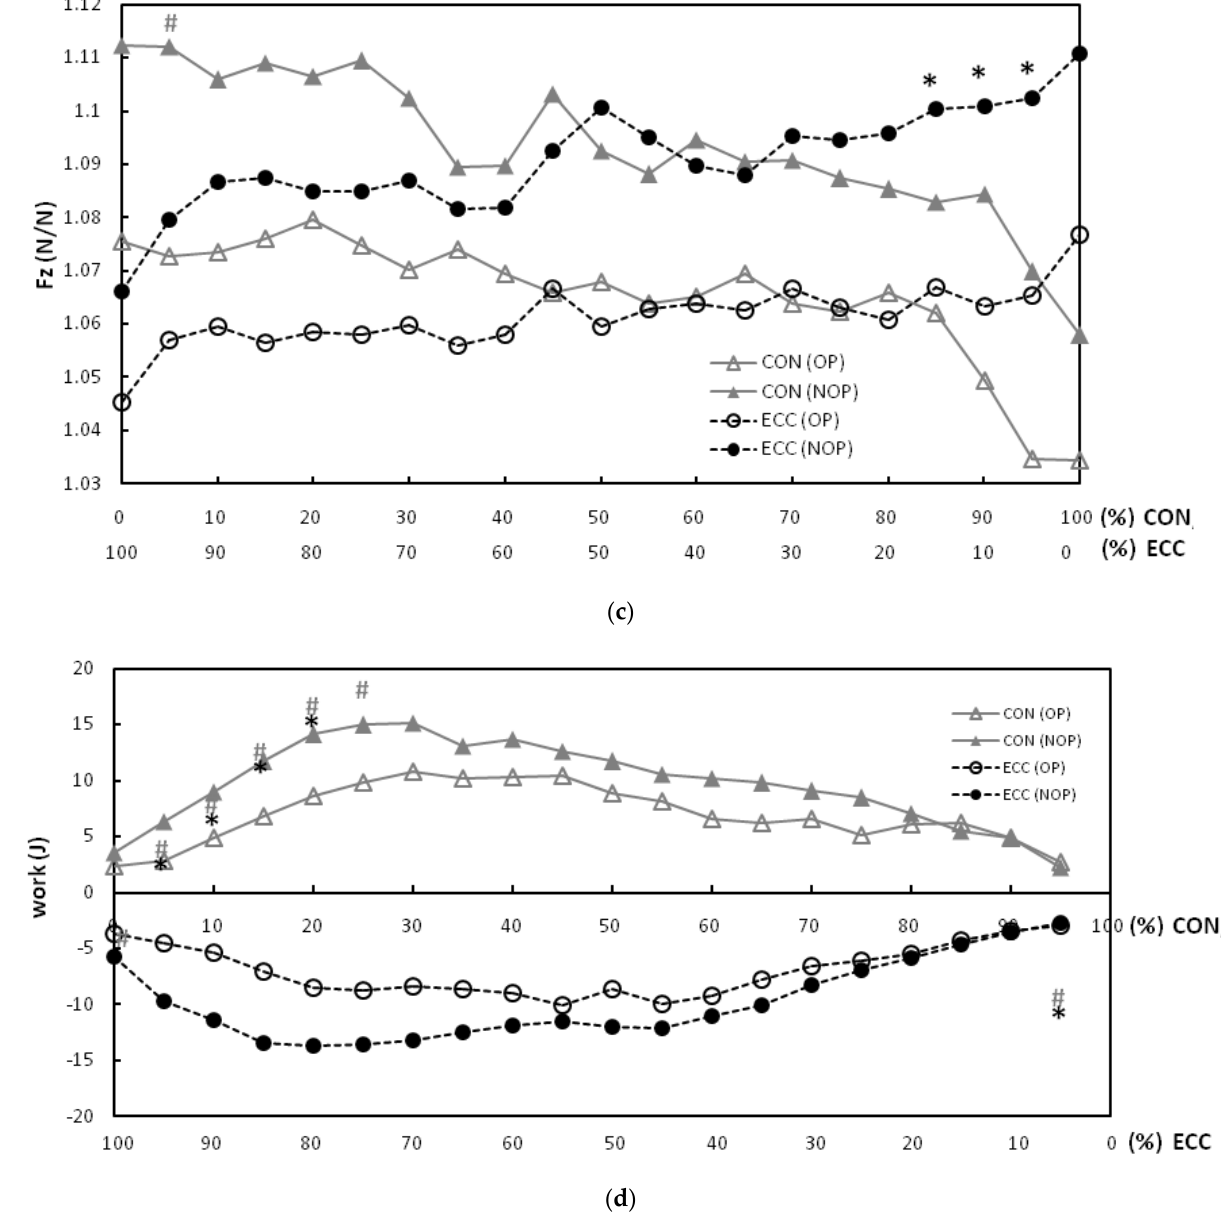
Figure 2. Records of the measured parameters (( a ); ankle joint angle, ( b ); angular velocity of the ankle joint, ( c ); vertical ground reaction force normalized with respect to body weight, ( d ); mechanical work) were analyzed over time scale intervals of 5 percent of the normalized time of the concentric and eccentric phases, from 0 to 100%. The significant differences in the concentric and eccentric phases are marked with # and *, respectively. The p’ s values in ( a ) ranged between 0.145 and <0.001 for # and between 0.075 and <0.001 for *; the p’ s values in ( b ) ranged between 0.687 and 0.001 for # and between 0.07 and <0.001 for *; the p’s values in ( c ) ranged between 0.836 and 0.049 for # and between 0.959 and 0.026 for *; and the p’ s values in ( d ) ranged between 0.836 and 0.002 for # and between 0.959 and 0.001 for *.